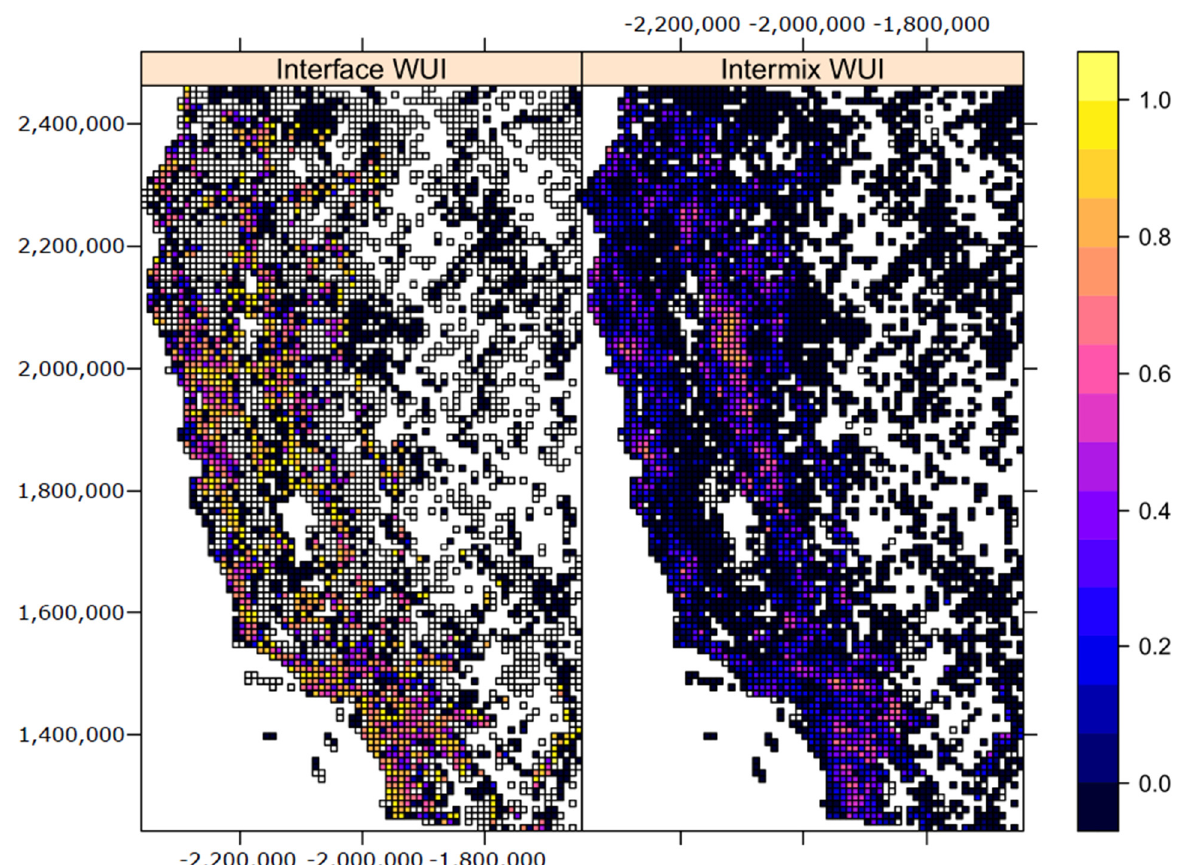
Figure 8. The spatial patterns of the Intersection over Union (IoU) measure of correspondence between zonal-based and point-based WUI maps. Left: a comparison of interface WUI maps; right: a comparison of intermix WUI maps. Rectangles depict the 10-by-10 km sample cells used in the comparison. Empty areas denote locations where there were no interface or intermix WUI areas in both mapping approaches.